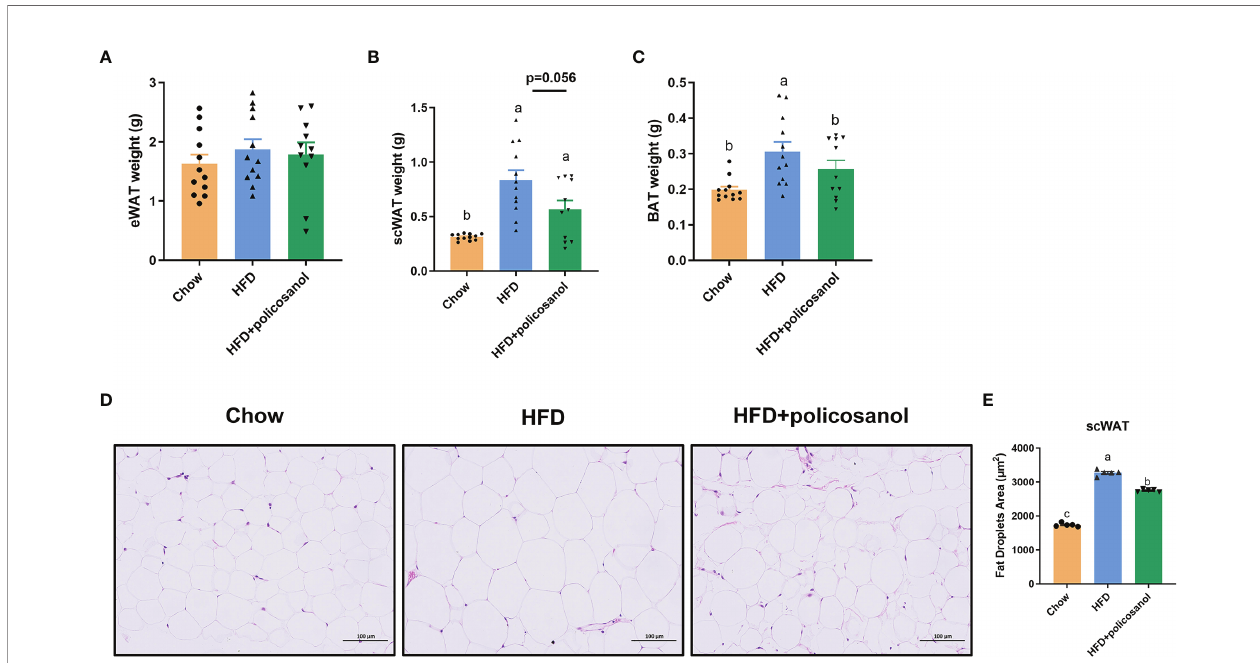
FIGURE 2 | Policosanol reduced lipid accumulation in the iWAT and BAT. (A – C) The tissue weight of eWAT, iWAT and BAT. Chow: The mice fed with chow diet (n = 12), HFD: the mice fed with high fat diet (n = 12), HFD + policosanol: The mice fed with high fat diet containing 0.5% policosanol (n = 11). (D) Representative H&E staining picture of adipocyte size of iWAT. (E) Statistical plot of fat droplet area in scWAT, n = 5 mice/group. Differences of data in mice subjects were assessed by one-way ANOVA. For all pictures, columns indicated with different letters (a-c) have signi fi cant difference, p < 0.05. ns, not signi fi